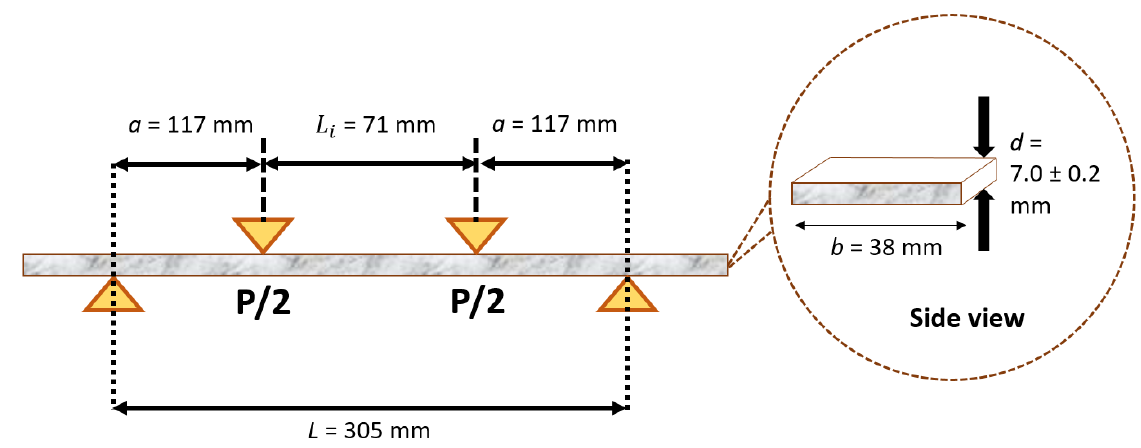
Figure 3. Schematic diagram of flexural creep setup as per ASTM D6272 with dimensions of flexural specimens.